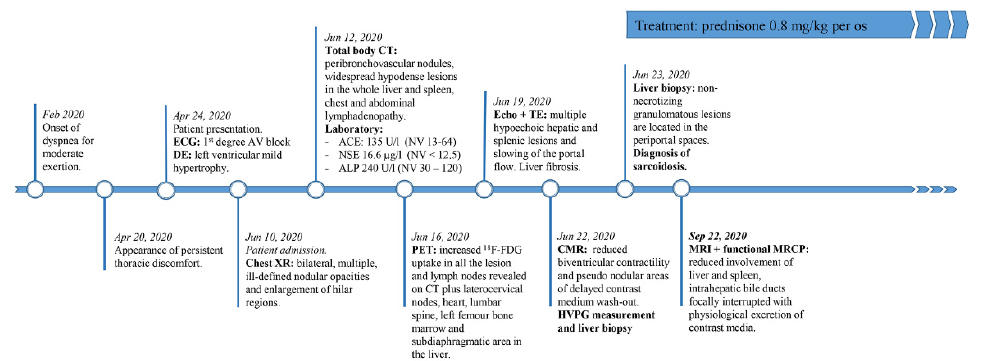
Figure 6. Information timeline. Abbreviations—ECG: electrocardiogram; DE: Doppler echocardiography; XR: X-ray; LYM: lymphocytes; NV: normal values; CT: computed tomography; ACE: angiotensin-converting enzyme; NSE: neuron-specific enolase; ALP: alkaline phosphatase; PET: positron emission tomography; Echo: echography; TE: transient elastography; CMR: cardiovascular magnetic resonance; HVPG: hepatic venous pressure gradient; MRCP: magnetic resonance cholangiopancreatography.